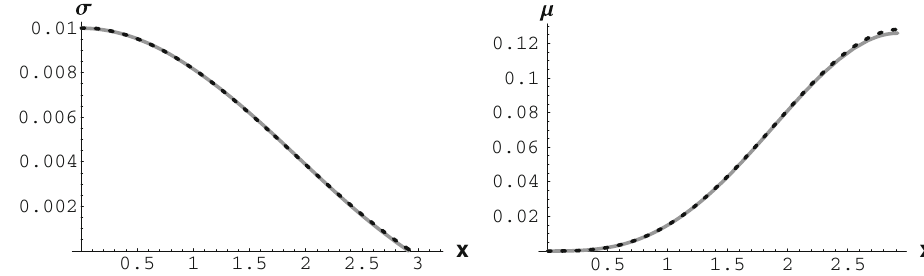
Fig. 1 Numerical solutions in the large coupling limit (dotted lines) and the present approximation (light solid lines) for σ( x ) and μ( x ) on the interval [ 0 ,π/ k ] , where g 2 = 0 . 1 and (cid:2) = 0 . 01